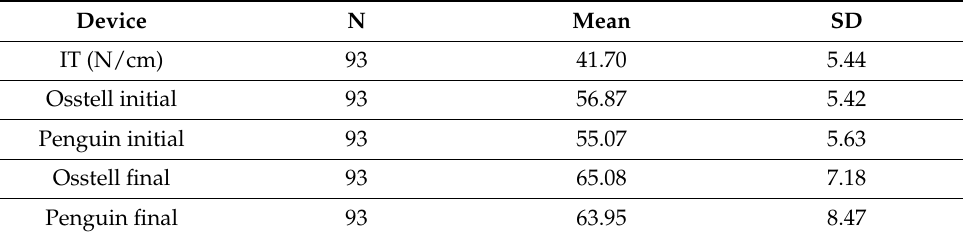
Table 2. The mean values of the three measurements for each device for all tested groups and the standard deviation.